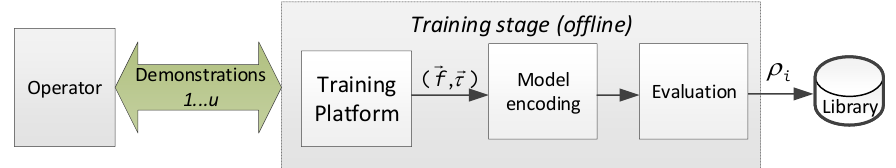
Figure 1. Training stage for gesture-based haptic guidance assistance. The operator performs a set of demonstrations for each gesture using a training platform. Then, each gesture is encoded as a Gaussian mixture models (GMM), evaluated and stored within the library Ω .